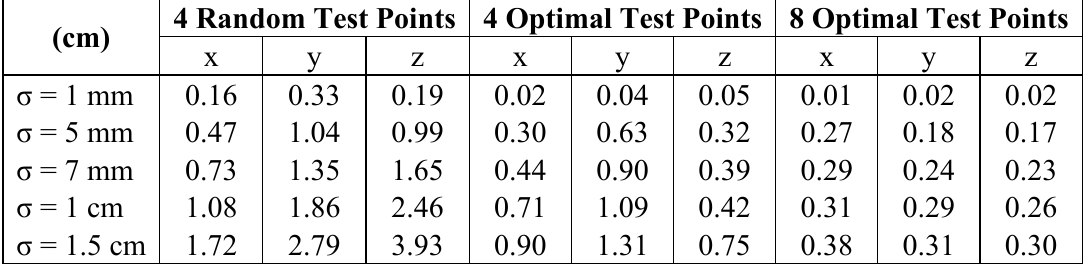
Table 3. Average error in the localization of beacons (in